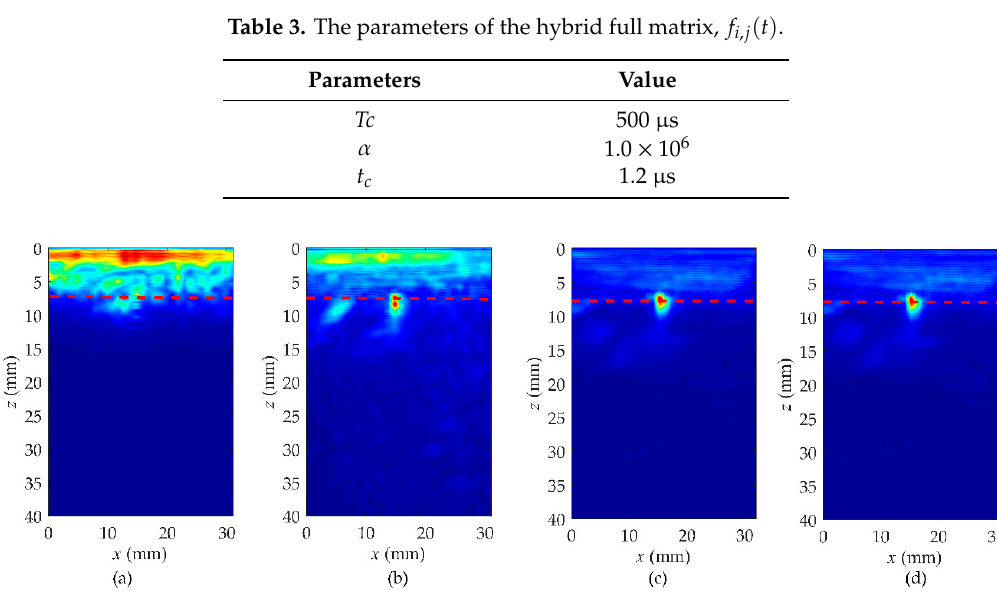
Figure 11. The study about the duration, T , of the time-windowed diffuse field signals in rail A. ( a ) T = 40 µ s, ( b ) T = 80 µ s, ( c ) T = 140 µ s, ( d ) T = 160 µ s.